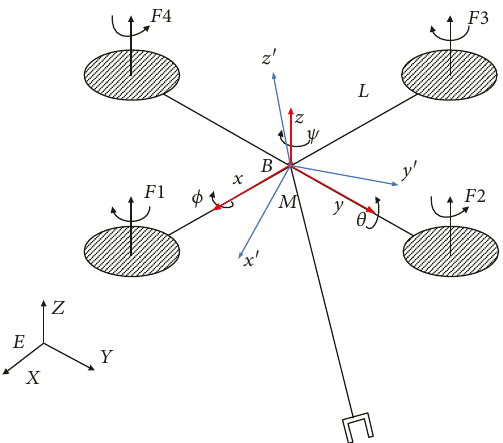
Figure 1: Quadrotor and manipulator system with the corresponding